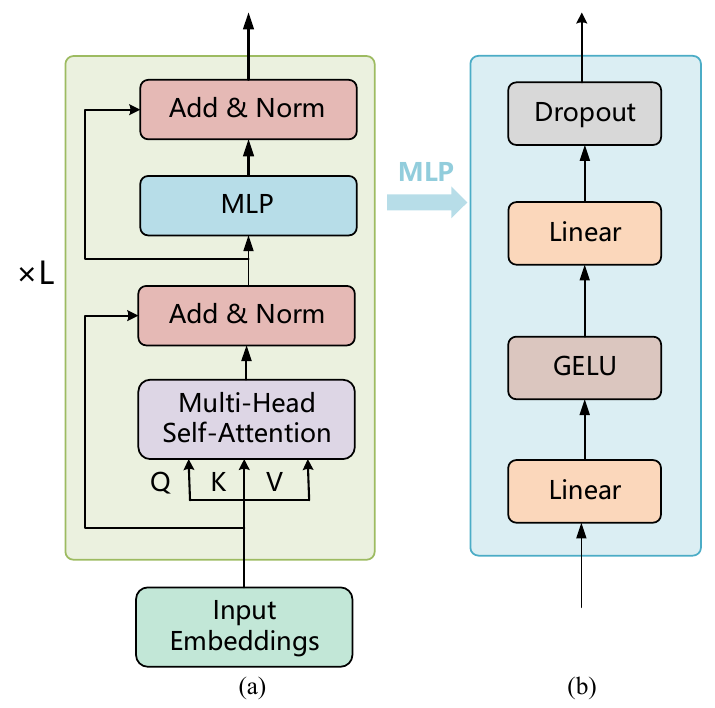
Figure 5. ( a ) ViT encoder module and ( b ) internal structure of the MLP layer.